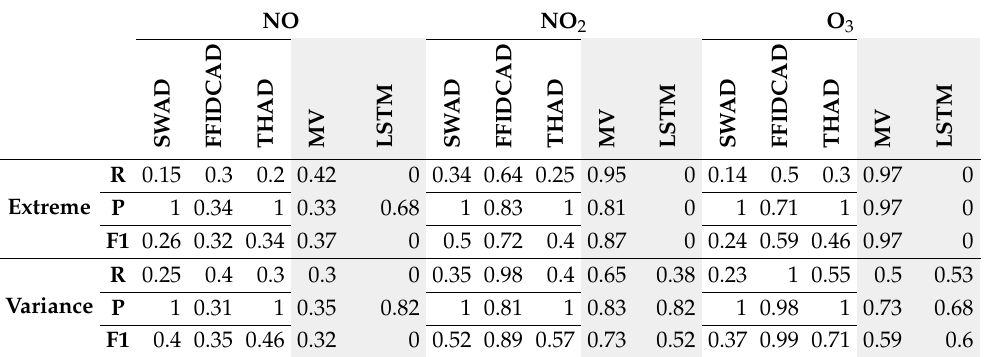
Table 2. Performance evaluation on synthetic